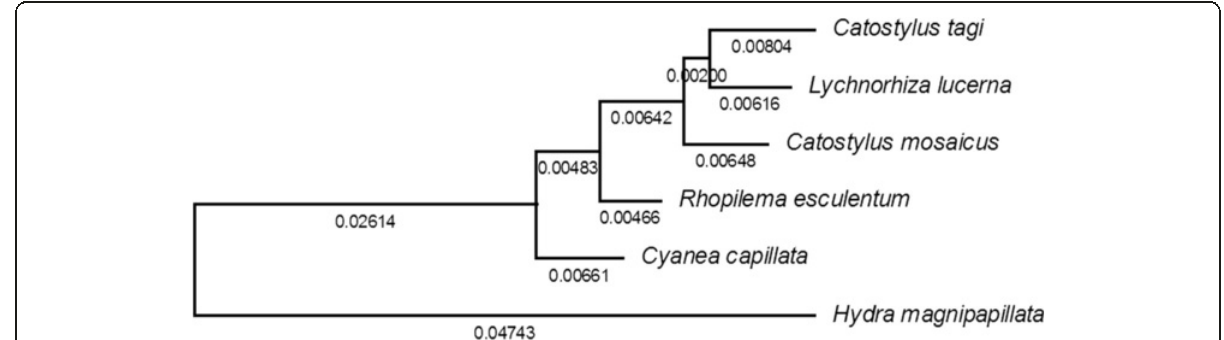
Fig. 1 Cladogram based on 18S rDNA of C. tagi, L. lucerna, C. mosaicus, R. esculentum, C. capillata and H.